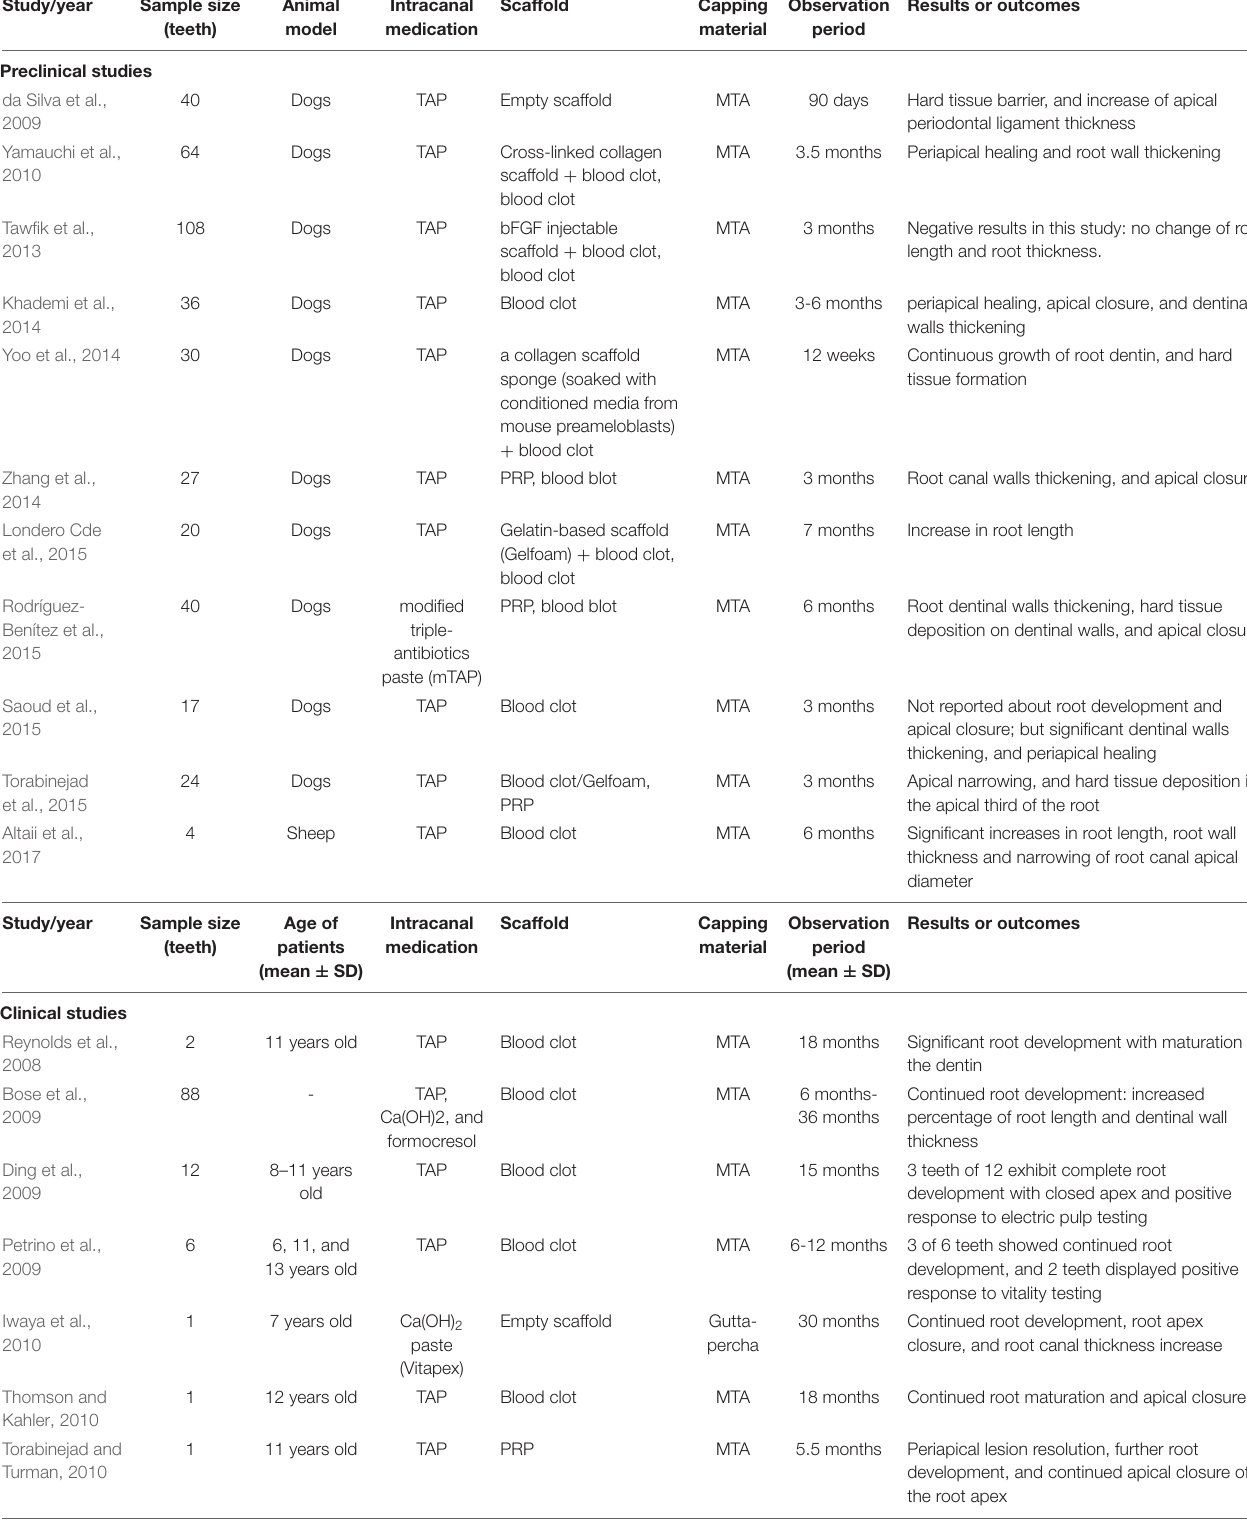
TABLE 2 | Current preclinical and clinical studies of cell-free